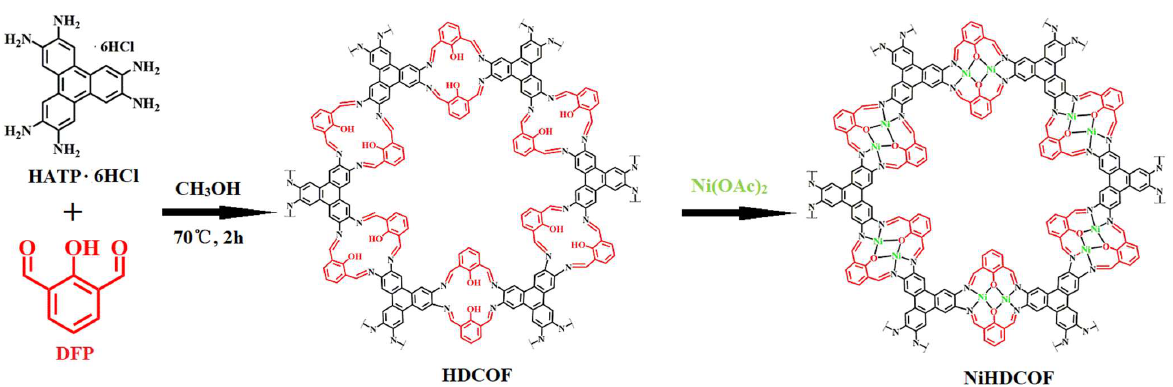
Figure 1. Scheme of the synthesis process of NiHDCOF.